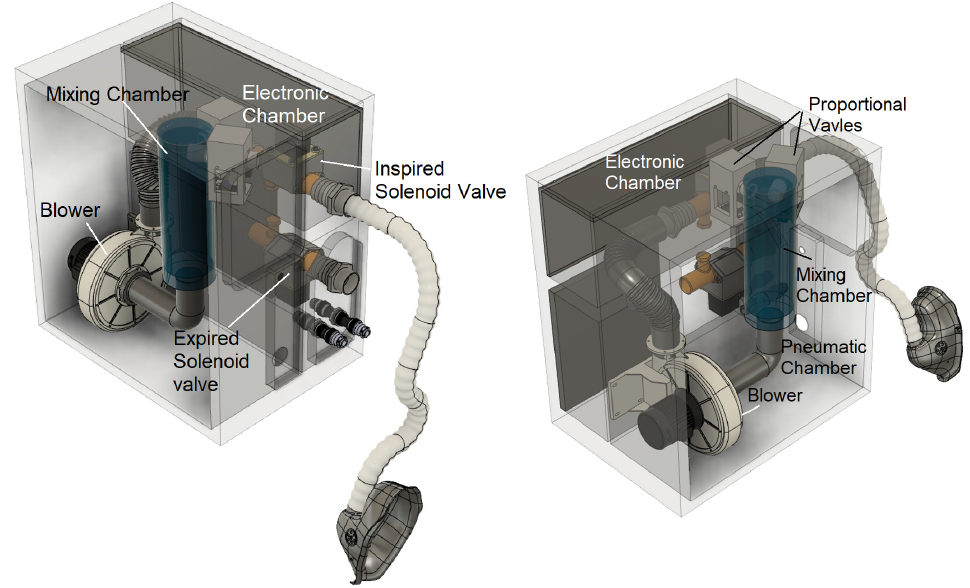
Figure 6. CAD Ventilator platform showing of electronic chamber and pneumatic